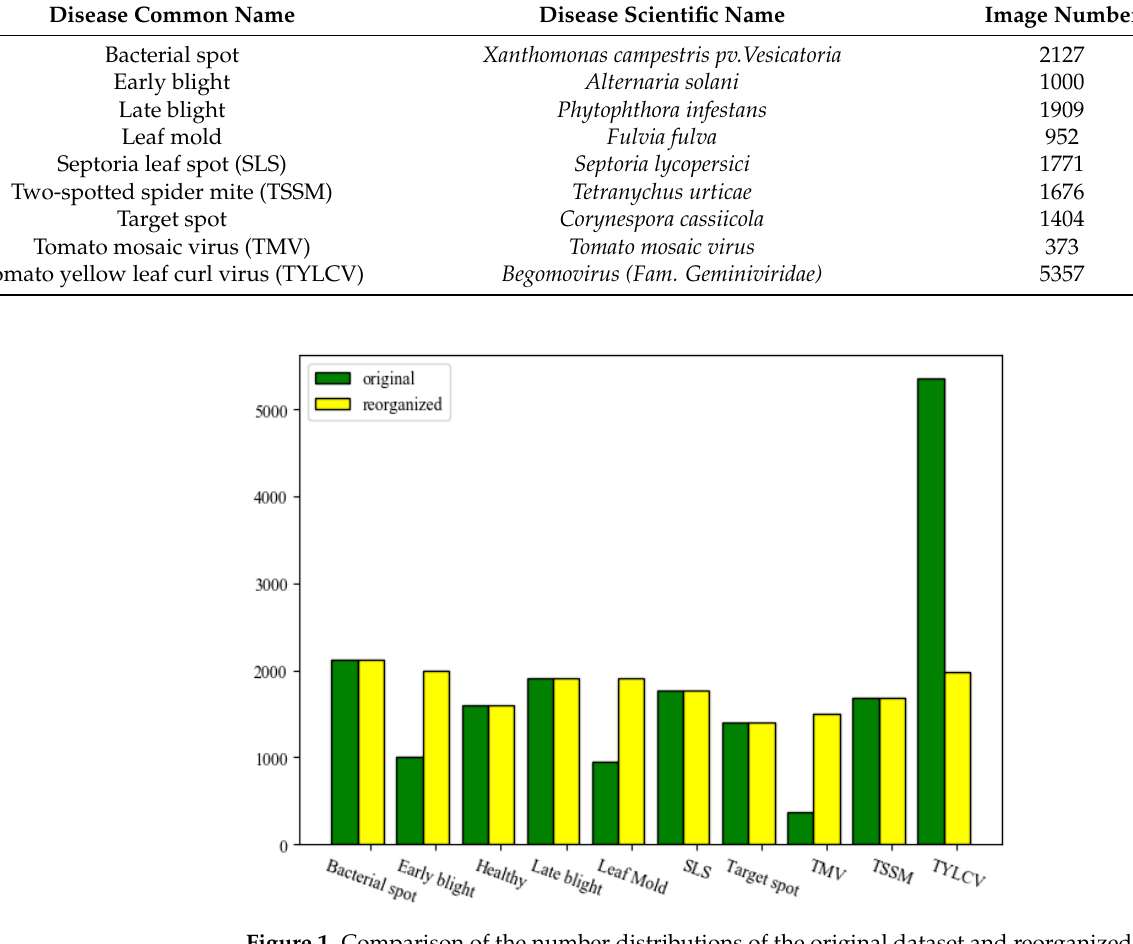
Figure 1. Comparison of the number distributions of the original dataset and reorganized dataset. Examples of each of the categories are provided in Figure 2. Images in the database were all RGB images. The symptoms of diseases varied from color changes to spots on leaves. Some diseases had similar symptoms, like obvious color change (e.g., early blight, late blight, and TYLCV). The dataset used in this work had many classes, containing a total of 10 types. When we want to classify high-dimensional data, but it is not clear whether the dataset has good separability—that is, the intervals between the same types are small, and the intervals between different types are large—we can use the t-distributed stochastic neighbor embedding (t-SNE) [30] algorithm to project high-dimensional data into two- or three-dimensional space for observation. If the data have separability in the low-dimensional space, the dataset is definitely divisible. To verify the separability of our dataset, we used the t-SNE algorithm to project the images into three-dimensional space and observed the separability of the dataset. The projection result is shown in Figure 3. Pictures of the same classes were on the same plane, while pictures of different classes were on different planes; that is, in a three-dimensional space, our dataset was separable. From Figure 3 we can clearly see that our data were highly